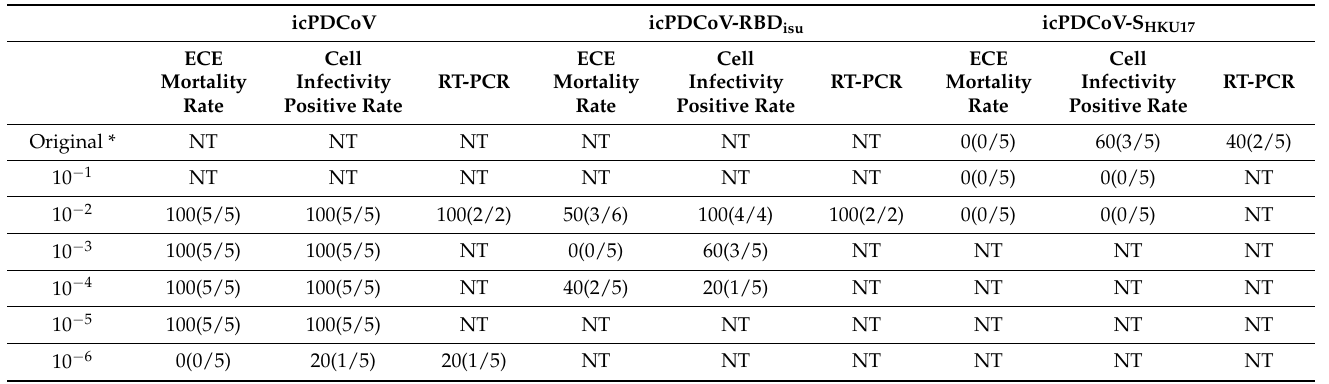
Table 1. Replication of chimeric porcine deltacoronaviruses in 5-day-old embryonic chicken eggs. icPDCoV icPDCoV-RBD isu icPDCoV-S